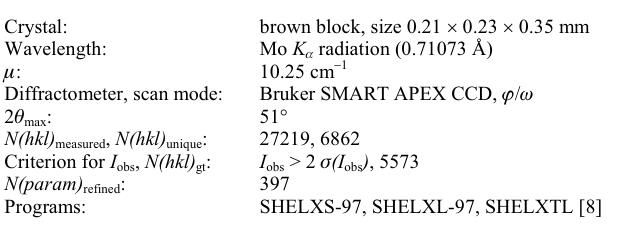
Table 1. Data collection and handling.